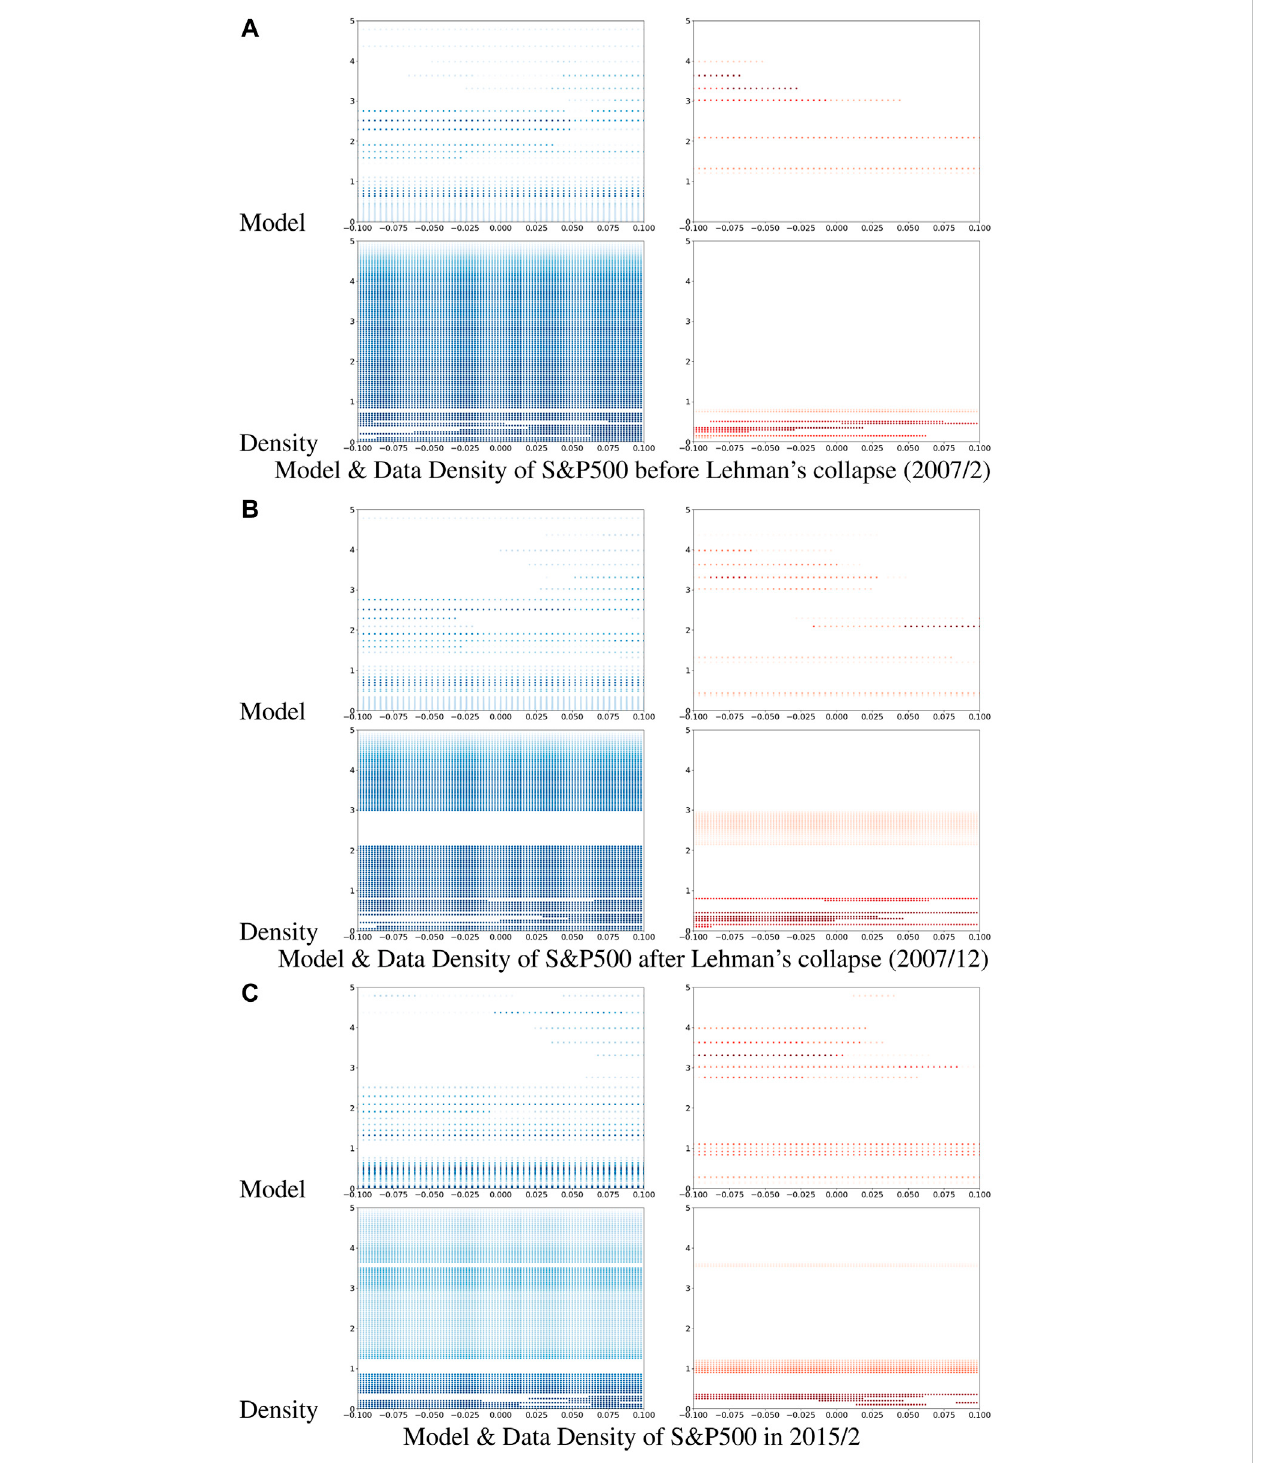
FIGURE 3 Model & Data Density of S&P500. (A) Model & Data Density of S&P500 before lehman ’ s collapse (2007/2). (B) Model & Data Density of S&P500 after lehman ’ s collapse (2007/12). (C) Model & Data Density of S&P500 in